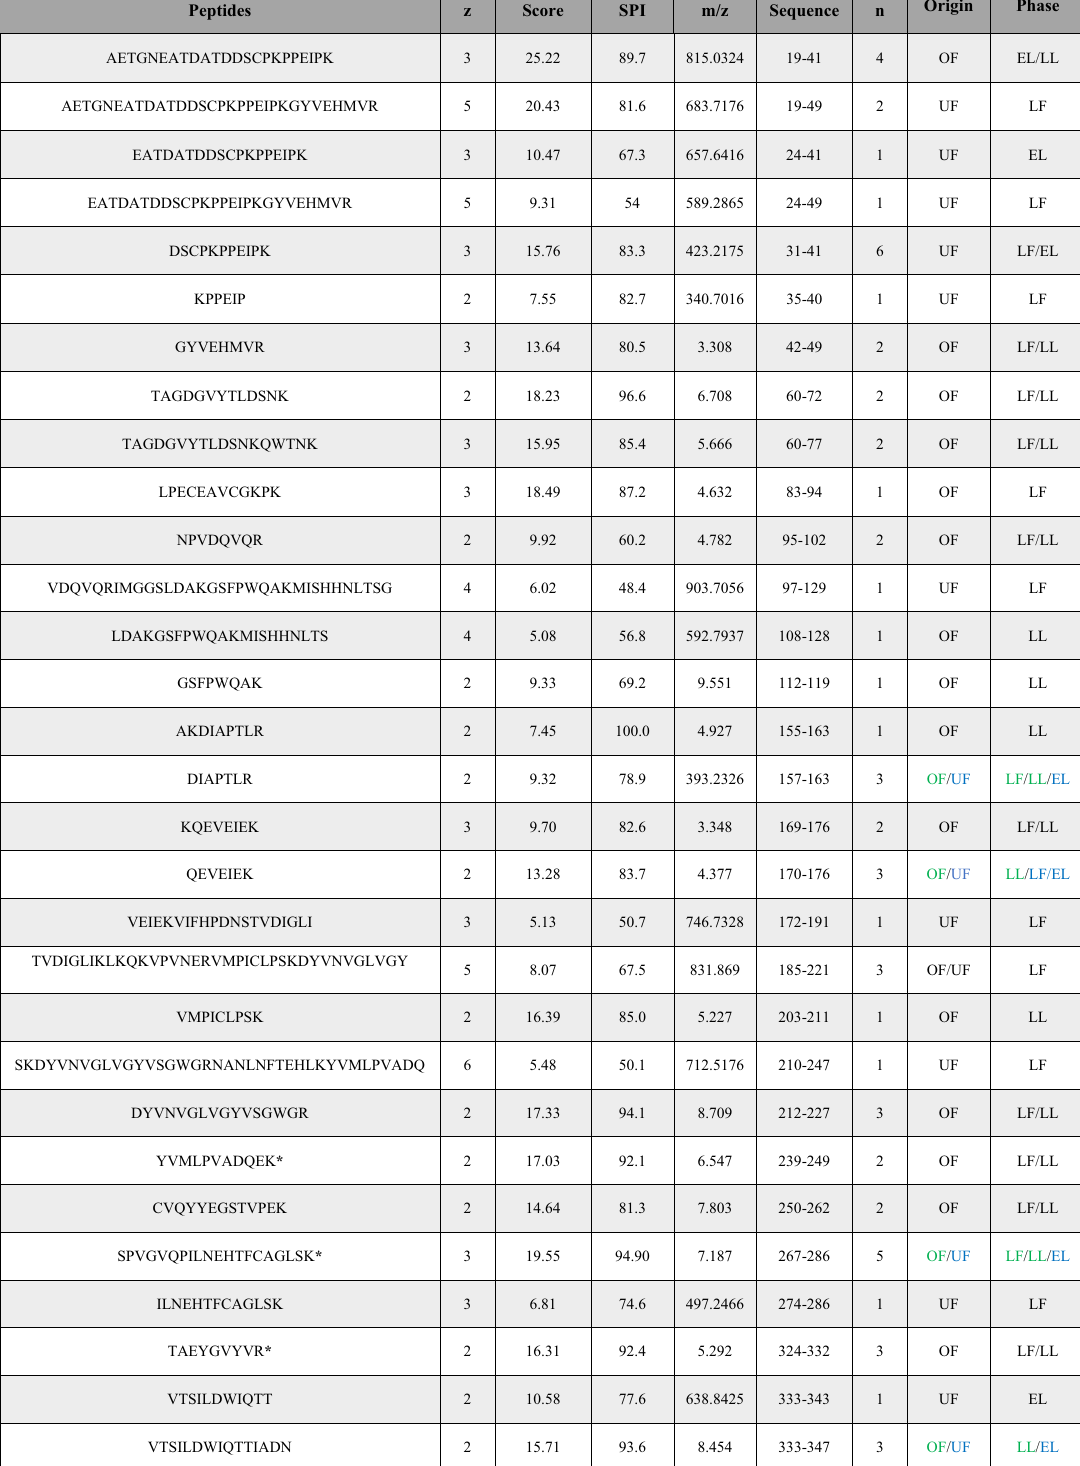
Table 1. Peptides corresponding to haptoglobin protein detected by HPLC-ESI-MS/MS. When the same peptide was detected several times, the data corresponding to the peptide with the highest score is shown. z: represents the charge of the detected ion or fragment. m/z: mass/charge ratio. Score: score based on signal strength. SPI: scored peak intensity. Sequence: order of appearance of amino acids in the protein. n: number of times that the peptide is detected. Origin: oviductal fluid (OF) or uterine fluid (UF). Phase: stage of the cycle when the peptide was detected: late follicular (LF), early luteal (EL), and late luteal (LL). Detected peptides from the gel stained with PageBlue Protein Staining and trimmed are identified with an asterisk (*). In the origin column black color is used when a peptide was detected in both OF and UF, green color is used for OF and blue color for